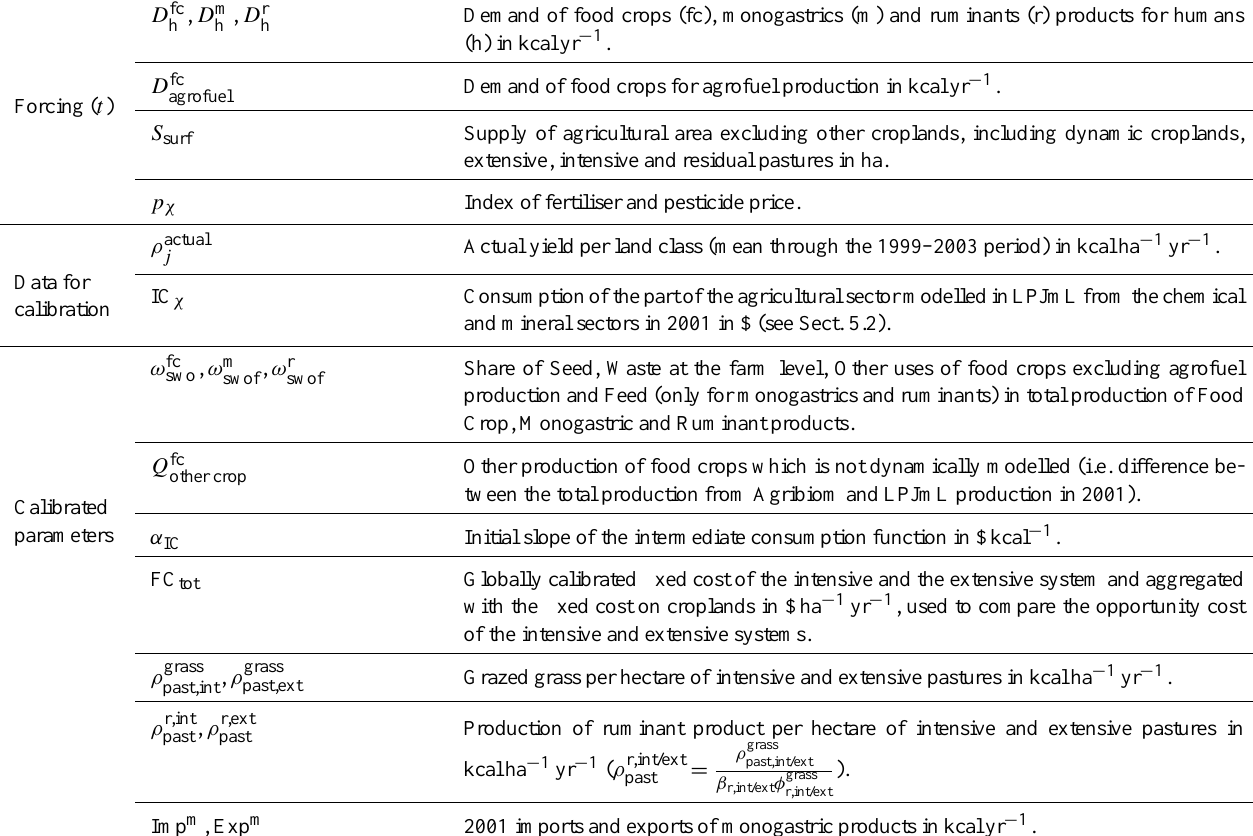
Table 9. Main notations. Except p w , they are all regional. ( t ) means evolving through the simulation. j is the subscript of land classes. cal